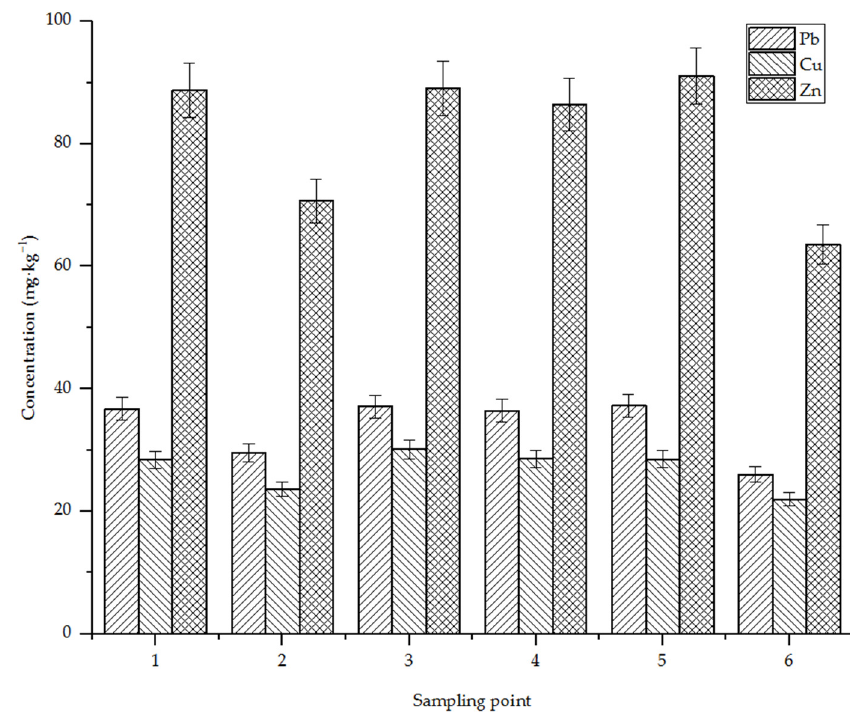
Figure 4. The pollution concentration of heavy metals in Liaohe estuary wetland.